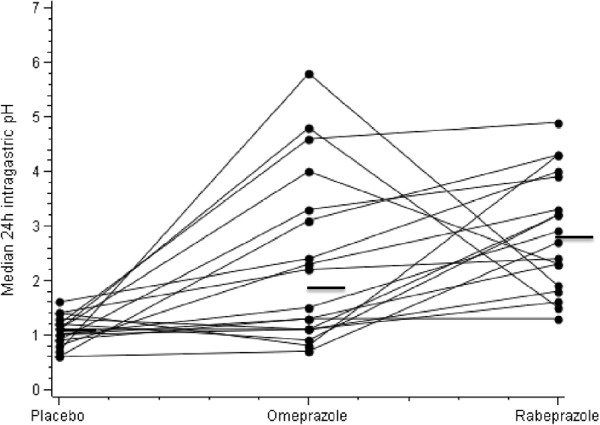
Twenty-four hour median pH individual values in 18 obese volunteer subjects after a single oral dose (20 mg) of rabeprazole, omeprazole or placebo during 24-hour gastric pH monitoring.